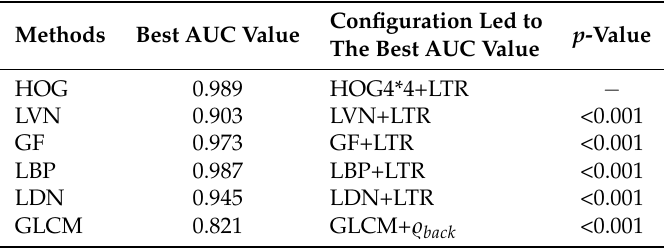
Table 7. Statistical analysis.